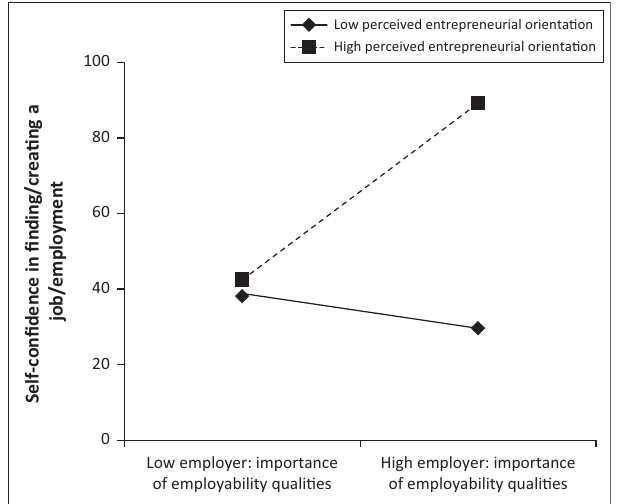
FIGURE 4: Interaction effects between perceived employer’s importance of employability qualities and perceived entrepreneurial orientation in predicting self-confidence in finding or creating a job or